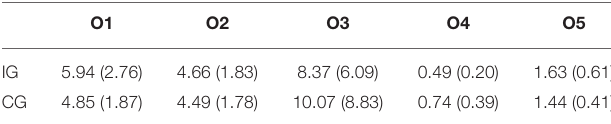
TABLE 2 | Mean (SD) observation duration (in min) of each phase for the respective group.